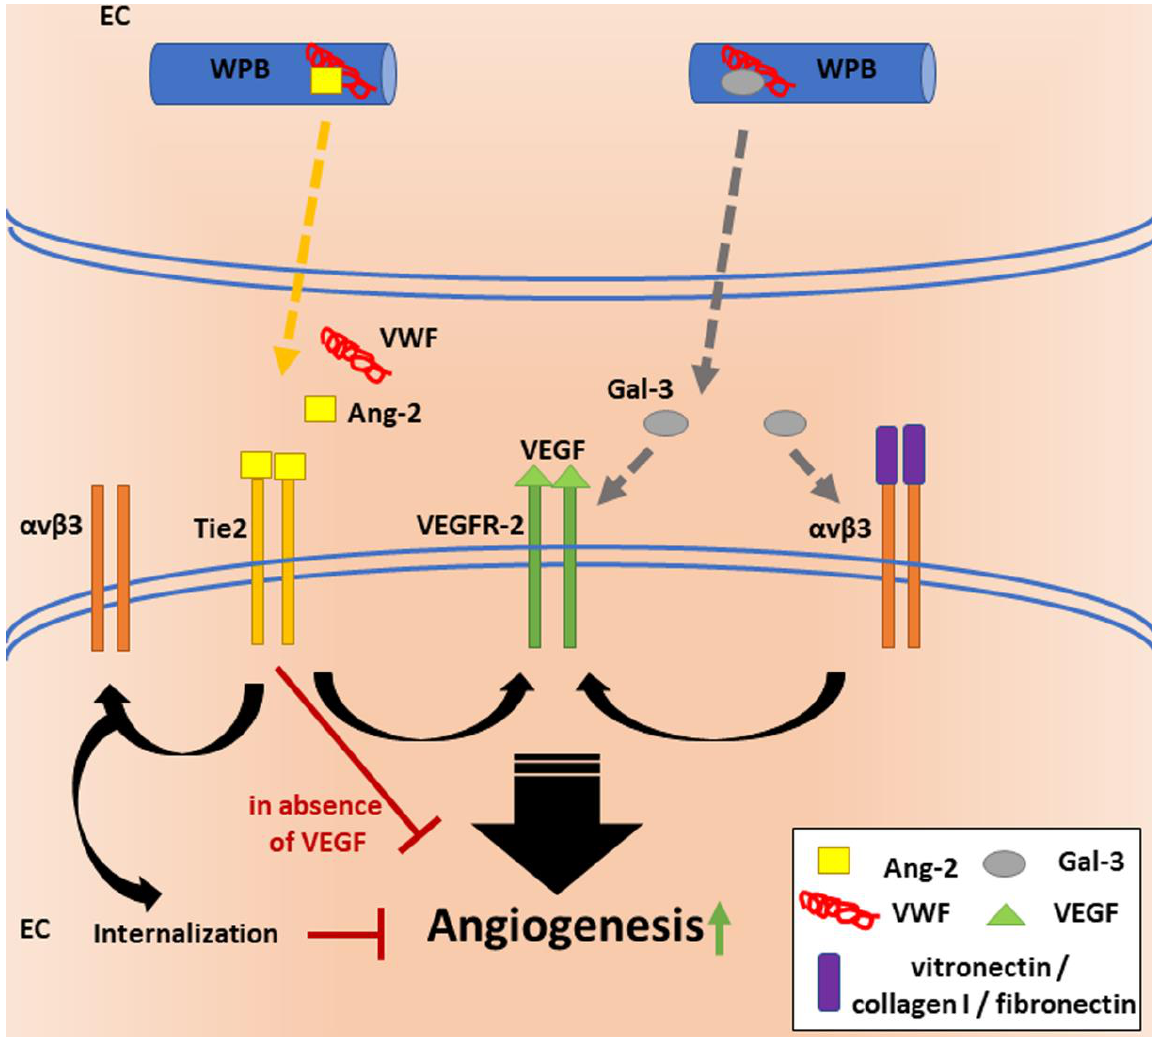
Figure 2. VWF’s regulatory functions in angiogenesis. VWF is essential for the formation of WPBs in endothelial cells (ECs) and regulates the storage and release of cargo proteins, such as growth factor Ang-2. Release of Ang-2 and subsequent binding to its receptor Tie-2 can destabilize blood vessels and promote angiogenesis cooperatively with VEGF signaling through VEGFR-2. In contrast, Tie-2 signaling has anti-angiogenic effects in the absence of VEGF. Ligand binding (e.g., vitronectin, fibronectin, collagen I) to α v β 3 has been shown to increase VEGFR-2 activity, to initiate downstream signaling and to thereby increase EC proliferation. Another protein stored in WPBs is the glycan-binding protein Gal-3. Gal-3 promotes angiogenesis through pathways that involve both α v β 3 and VEGFR-2. Thus, VWF may regulate angiogenesis at multiple levels. Intracellularly, it has anti-angiogenic effects when regulating the storage of proangiogenic factors, but it might also function as a proangiogenic extracellular ligand.